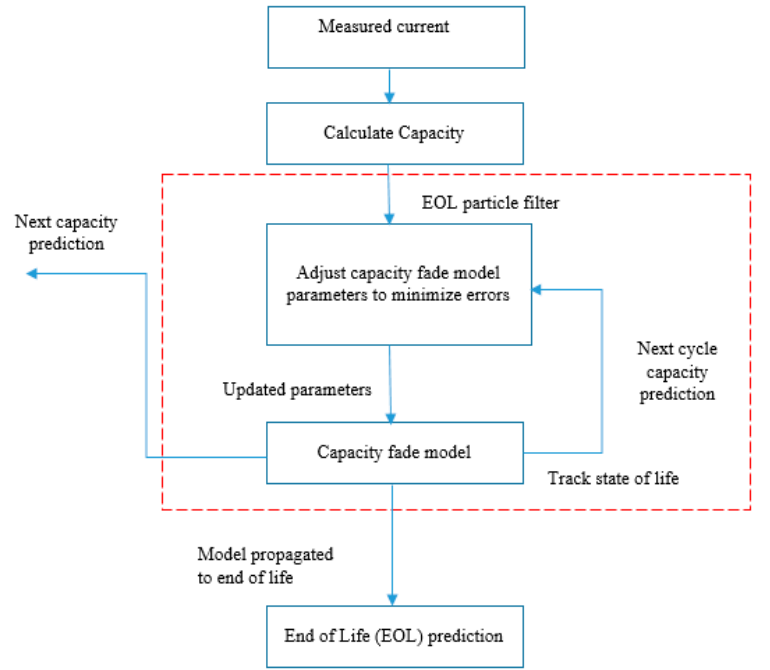
Figure 4. End of Life (EOL) prediction.